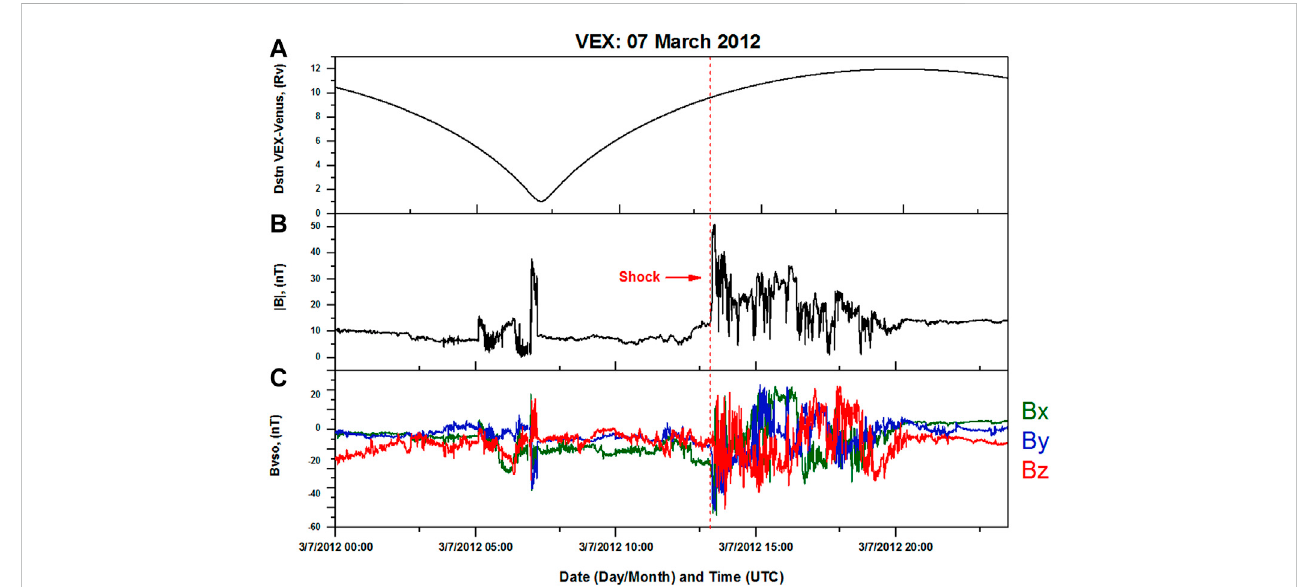
FIGURE 6 (A) AltitudeoftheVExorbitinVenusian ’ sradii(Rv), (B) totalmagnetic fi eld,and (C) componentsofmagnetic fi eldobservationsbyVExinVSOcoordinates, wherexisinthepositivedirectionoftheSunalongtheSun – Venusline,yispositiveinthedirectionopposing orbitalmotionintheVenusorbitalplane,andzis positive in the northward direction and parallel to the pole of the orbital plane. The vertical red dotted line marks the observed shock arrival (13:28 UT, 07 March 2012).